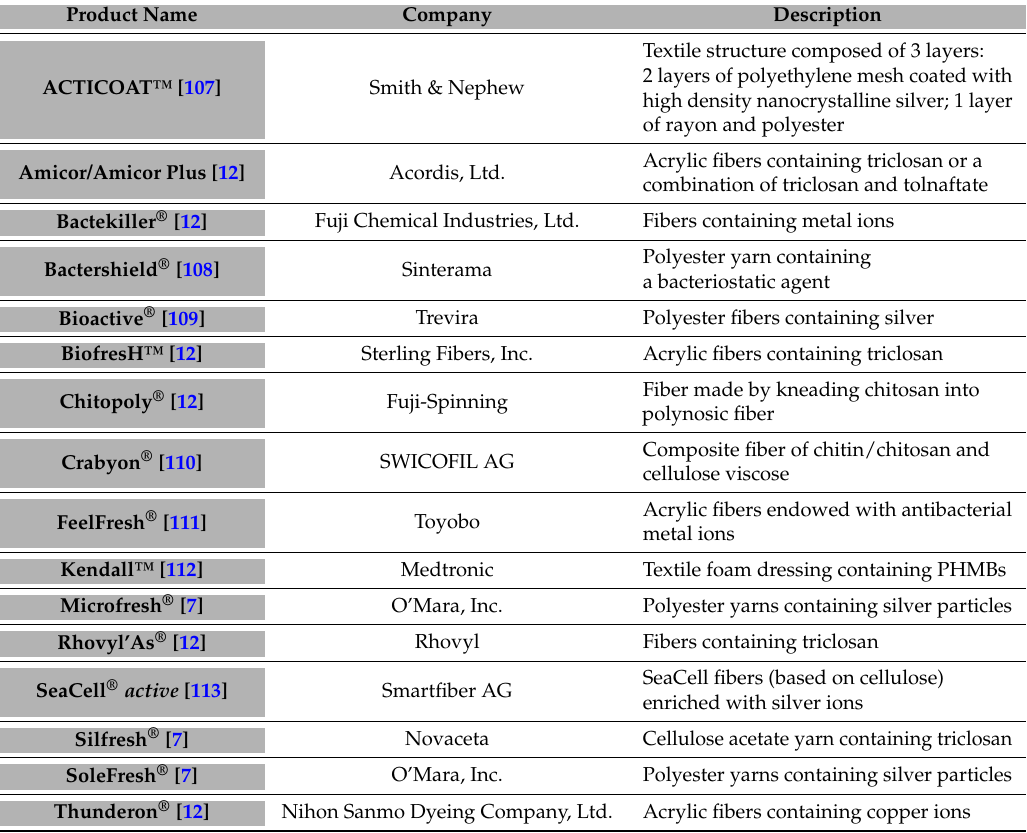
Table 4. Commercially available antimicrobial textile fibers or